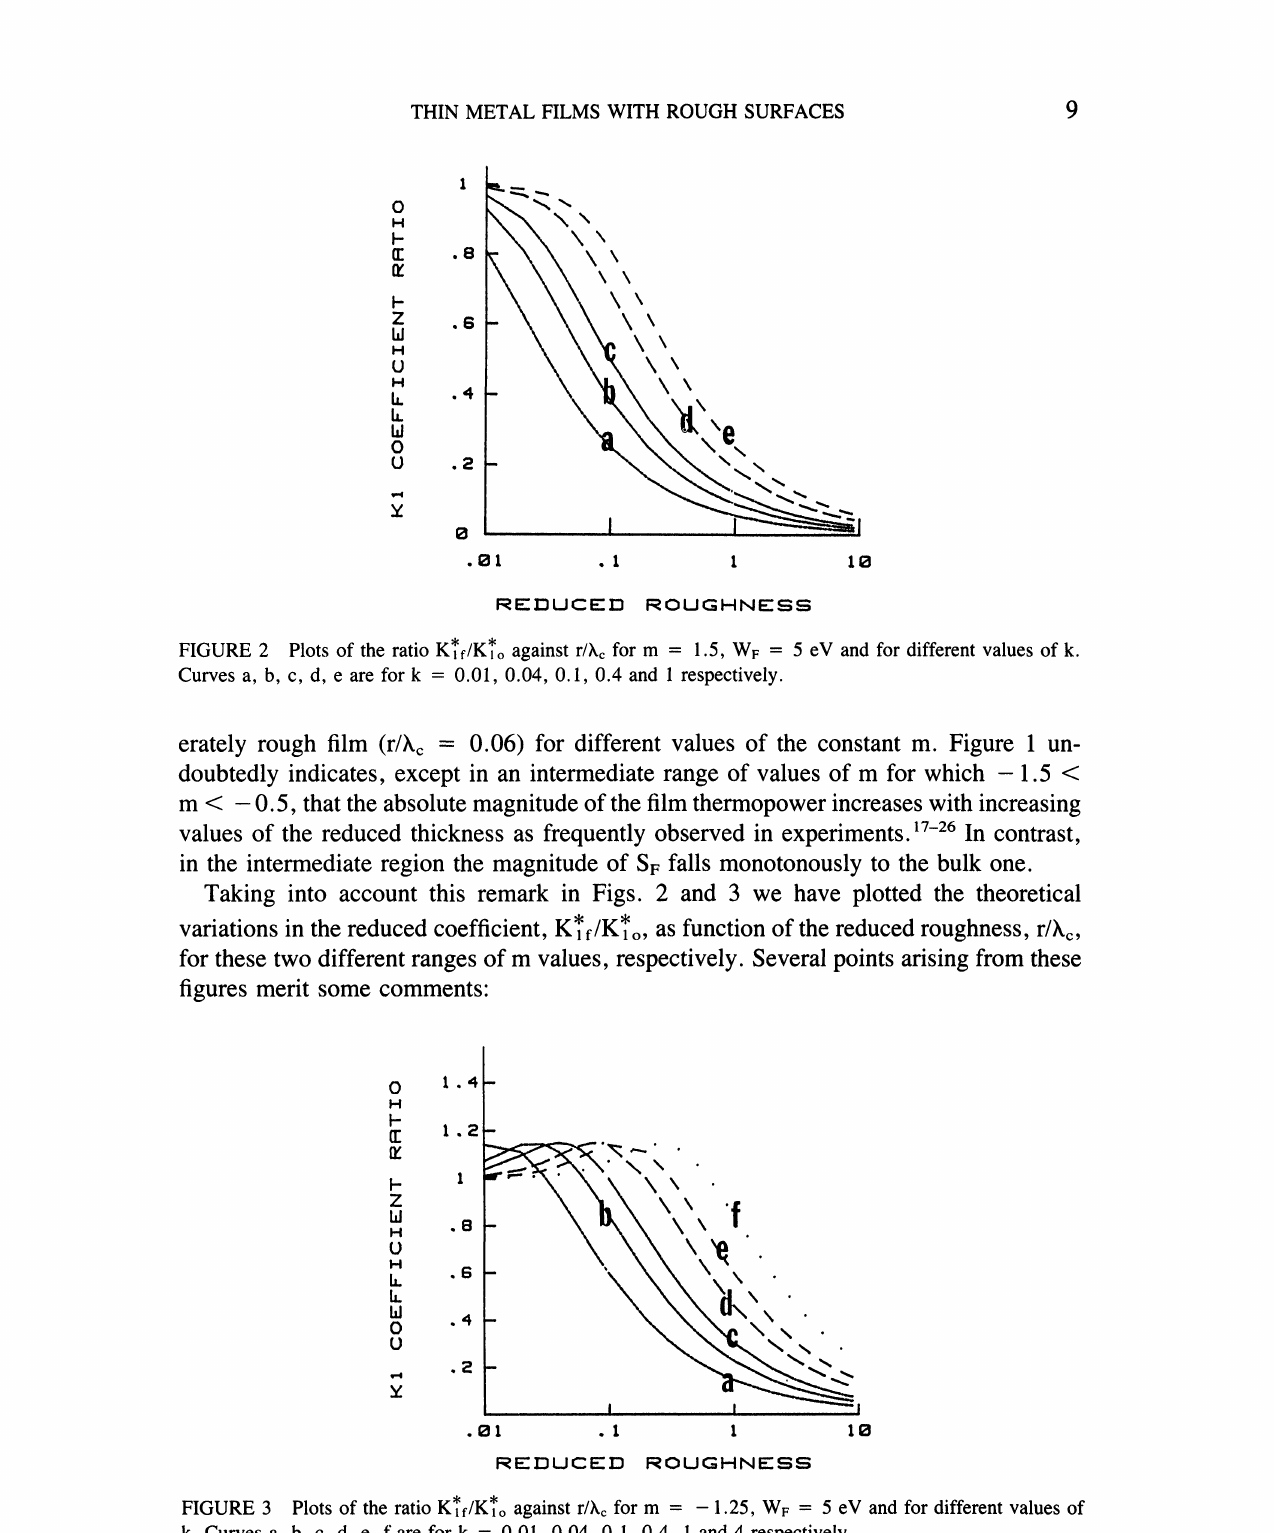
FIGURE 3 Plots of the ratio K f/Klo against r/hc for rn 1.25, WF 5 eV and for different values of k. Curves a, b, c, d, e, f are for k 0.01, 0.04, 0.1, 0.4, and 4